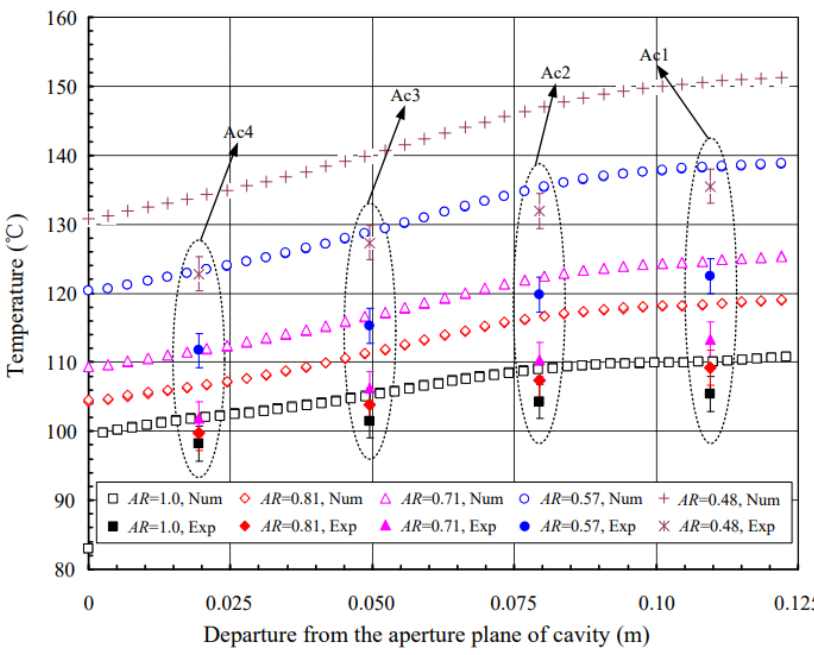
Figure 10. Temperature variation with departure from the aperture plane of the cavity. Reprinted with permission from Ref. [23]. 2017, Elsevier.